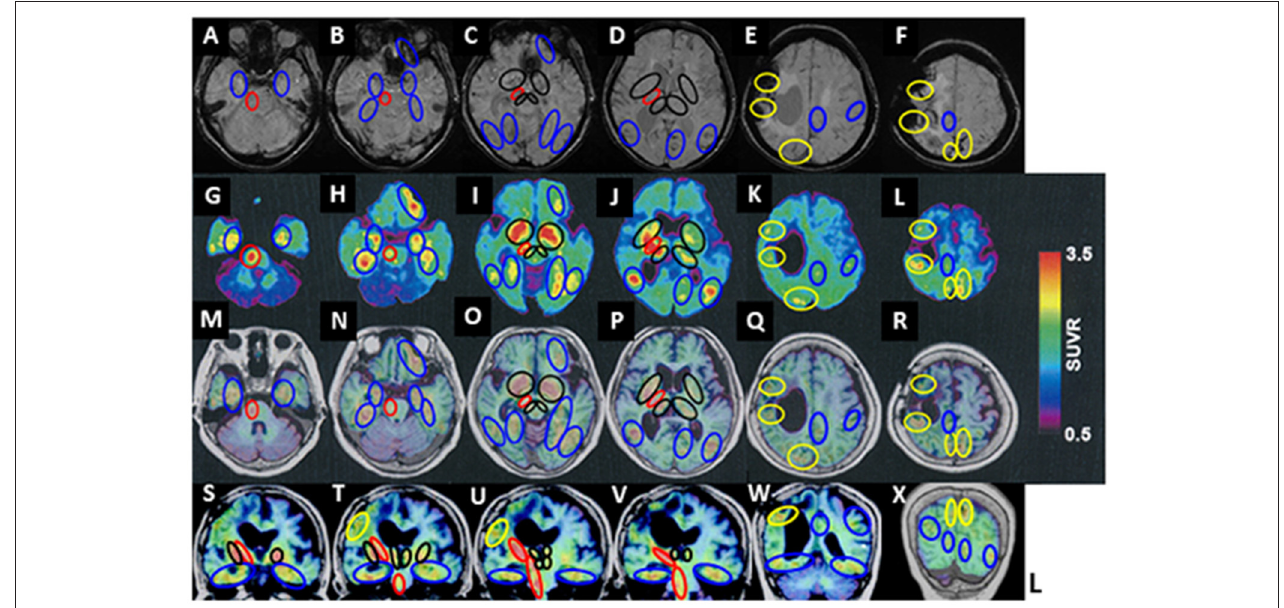
FIGURE 2 | 18 F-THK5351 imaging and MRI of the patient’s brain. (A–F) Susceptibility-weighted MRI. (G–L) 18 F-THK5351. (M–R) 18 F-THK 5351 on transverse MRI (T1-weighted images). (S–X) 18 F-THK 5351 on coronal MRI (T1-weighted images). 18 F-THK5351 retentions areas were observed in the pyramidal tract at the pontine level, the cerebral peduncle of the midbrain, and the internal capsule, all at the right side (red circles: A-G-M-S , B-H-N-T , C-I-O-U , and D-J-P-V ). The bilateral substantia nigra of the midbrain, the globus pallidum, the anterior caudate nuclei, amygdala, and the medial areas of thalamus ( black circles : C-I-O-U and D-J-P-V ) were considered the off-target retentions of 18 F-THK5351 binding to MAO-B. They were also visible along the previous lobar hemorrhagic lesions in the right frontal lobe and the left parietal cortex, as well as an asymptomatic old cortical SAH lesion in the right parietal cortex (yellow circles: E-K-Q-W and F-L-R-X ). Additional 18 F-THK5351 retentions were observed in the bilateral medial temporal areas (blue circles: A-G-M-S and B-H-N-T ), the left anterior frontal cortical areas (blue circles: B-H-N-T and C-I-O-U ), the posterior areas in bilateral temporal cortices, and the bilateral fusiform, lingual, and parahippocampal gyruses (blue circles: C-I-O and D-J-P